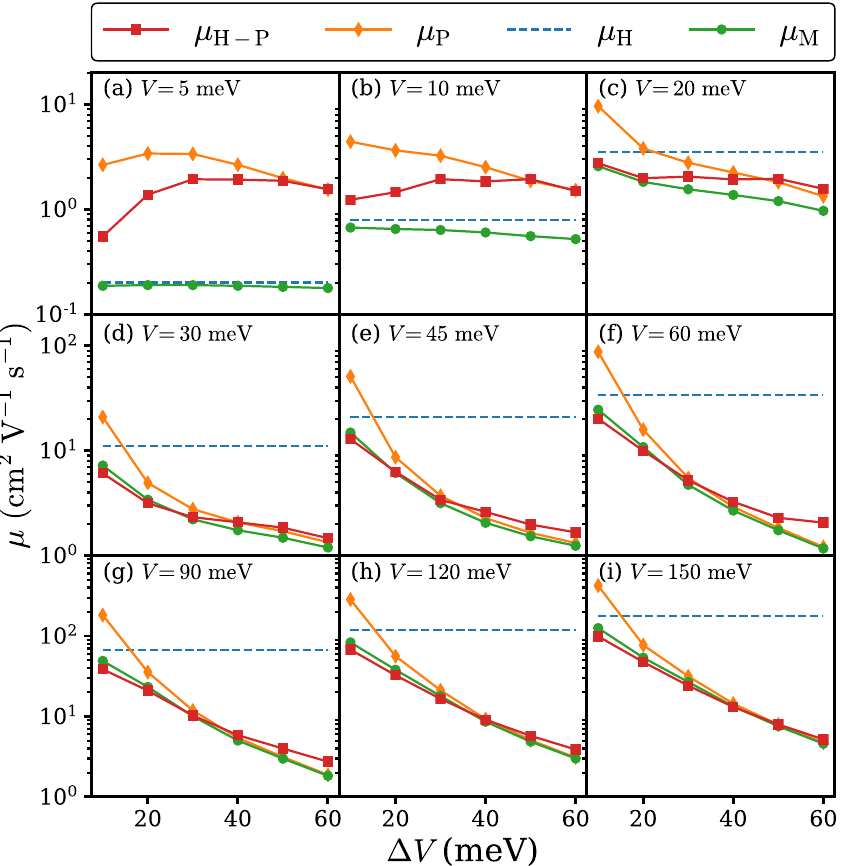
Fig. 1 Carrier mobility at 300 K calculated based on the Holstein – Peierls model ( μ H-P ), Holstein model ( μ H ), Peierls model ( μ P ), and Matthiessen ’ s rule ( μ M ) with various transfer integral V and transfer integral fl uctuation Δ V . From a to i the transfer integrals are 5, 10, 20, 30, 45, 60, 90, 120, and 150 meV respectively. Other parameters relevant to the carrier mobility such as local EPC constants are fi xed with values taken from rubrene. The parameters for the Holstein (Peierls) model is the same as that of Holstein – Peierls model except that the nonlocal (local) EPC is left